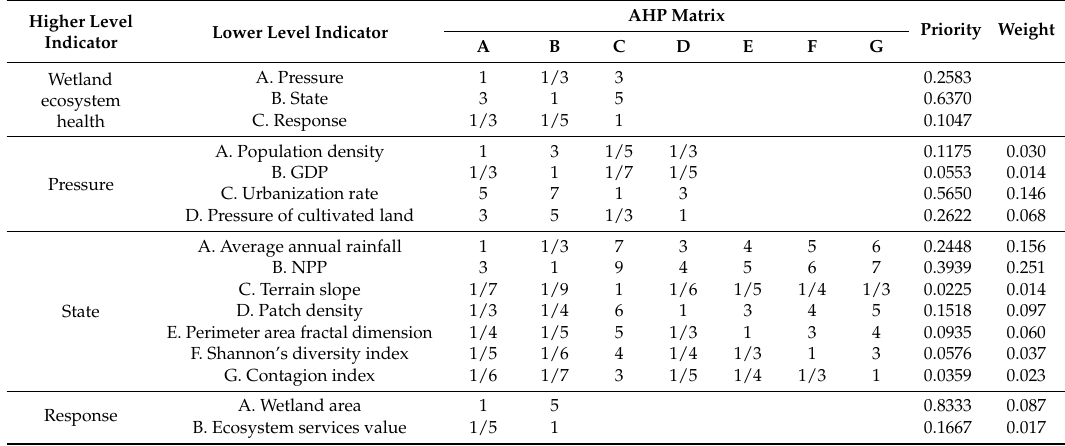
Table 2. Analytic hierarchy process (AHP) matrix and weight of indicators.